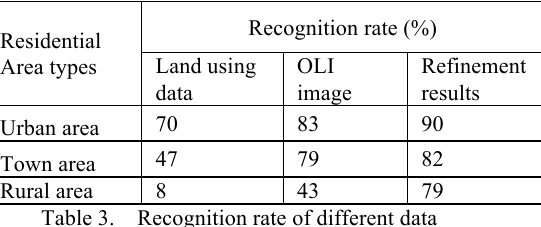
Table 3. Recognition rate of different